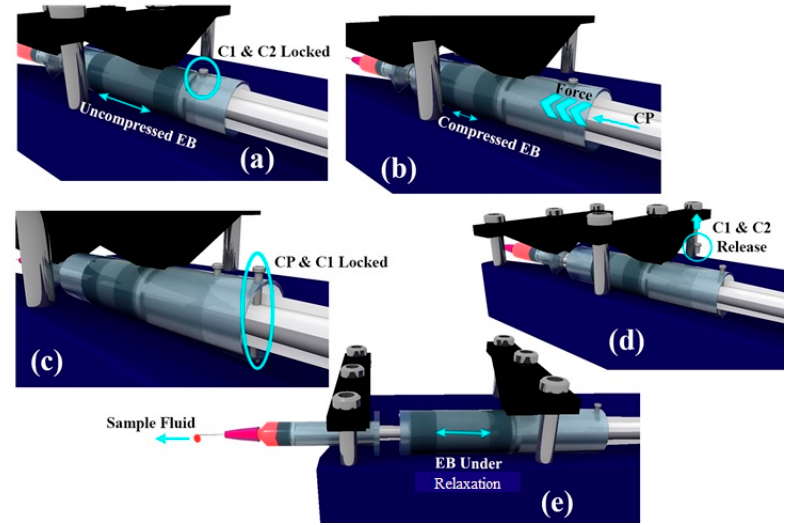
Figure 2. Schematic depicting the working of the pump. ( a ) C1 and C2 are locked using pin. ( b ) EB is compressed using CP. ( c ) CP and C1 are locked. ( d ) C1 and C2 are released thereby initiating the pumping action. ( e ) Image illustrating the pumping action while EB is relaxing.